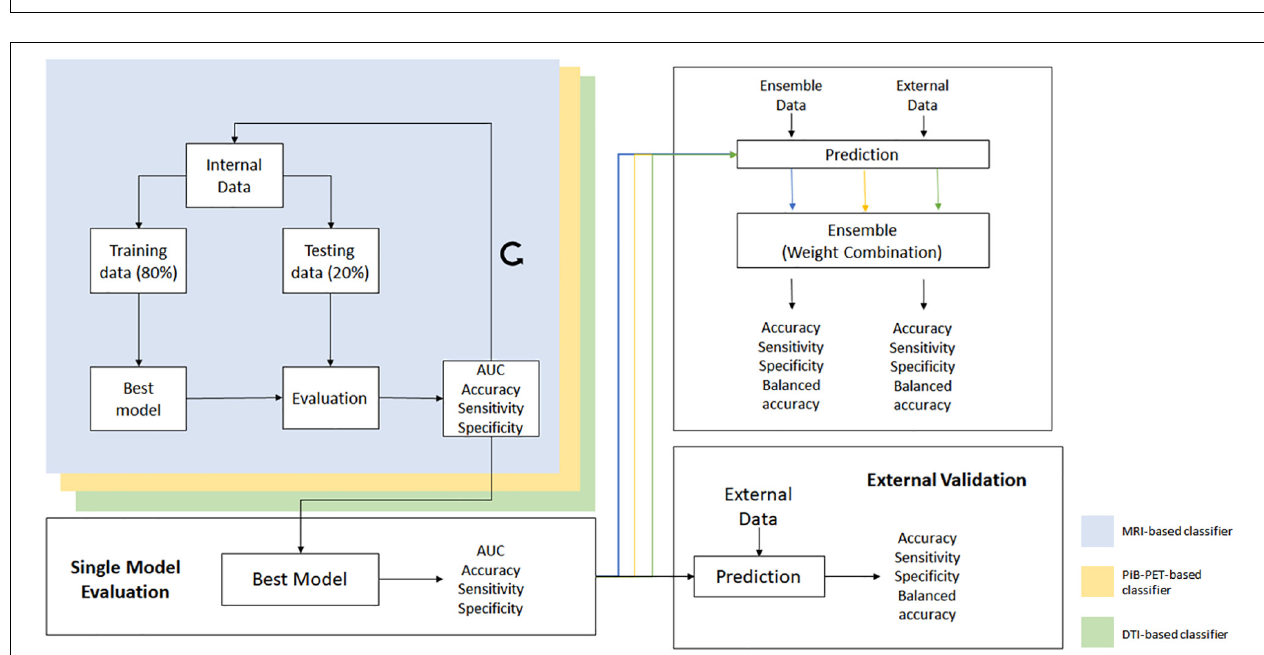
FIGURE 2 | Overall scheme of all processes used for the construction and validation of the individual models and ensemble.